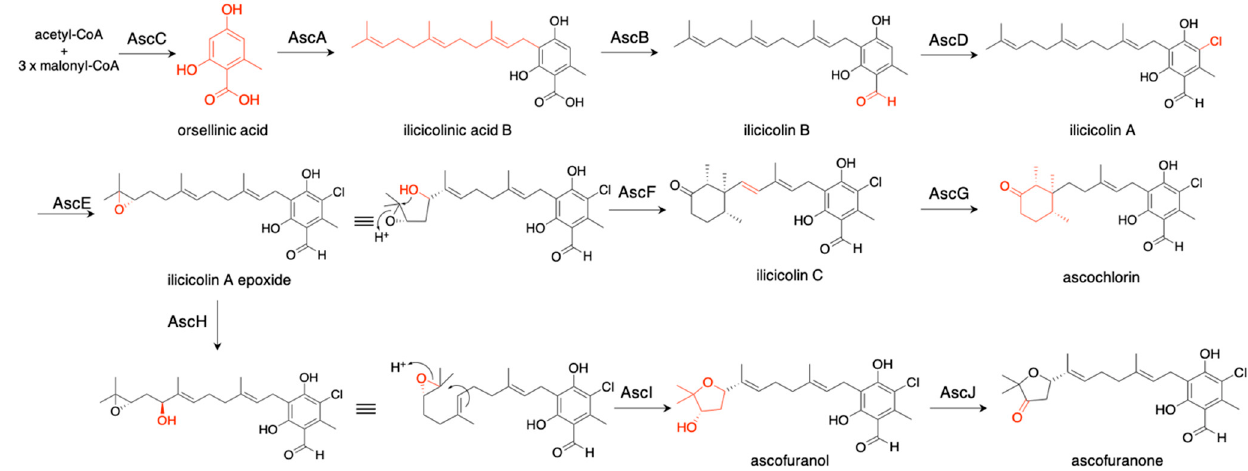
Figure 7. Biosynthetic pathways of ascochlorin and ascofuranone. The red fonts indicate the structural change after each biosynthetic reaction.